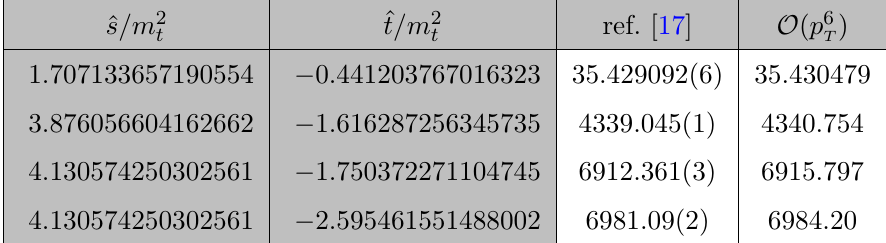
α 2 ) with the numerical results of ref. S